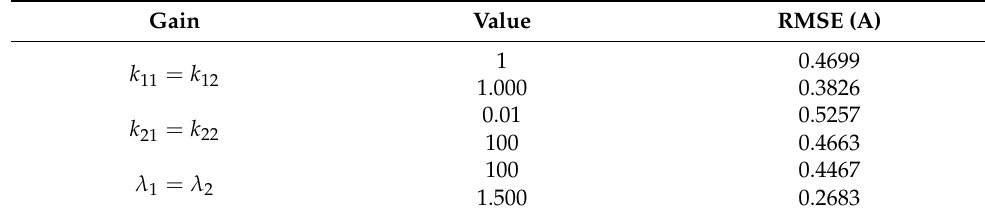
Table 3. RMSE in the gain adjustment.